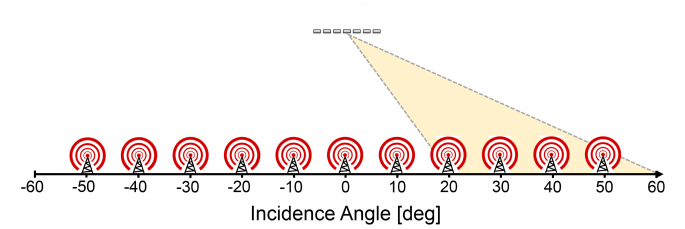
Figure 21. Scenario D: 11 interferers are present. They are located inside and outside of the swath. Locations range from − 50° to 50° in 10° intervals. Transmitting frequencies range from − 60 MHz to 25 MHz in baseband with 5 MHz